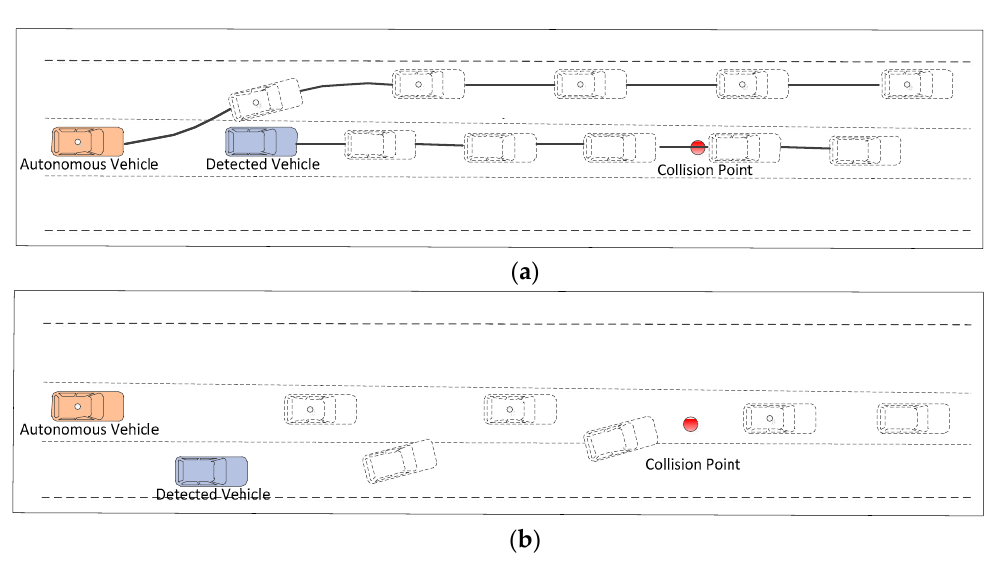
Figure 9. Collision avoidance: ( a ) collision avoidance in the space dimension; ( b ) collision avoidance in the time dimension.